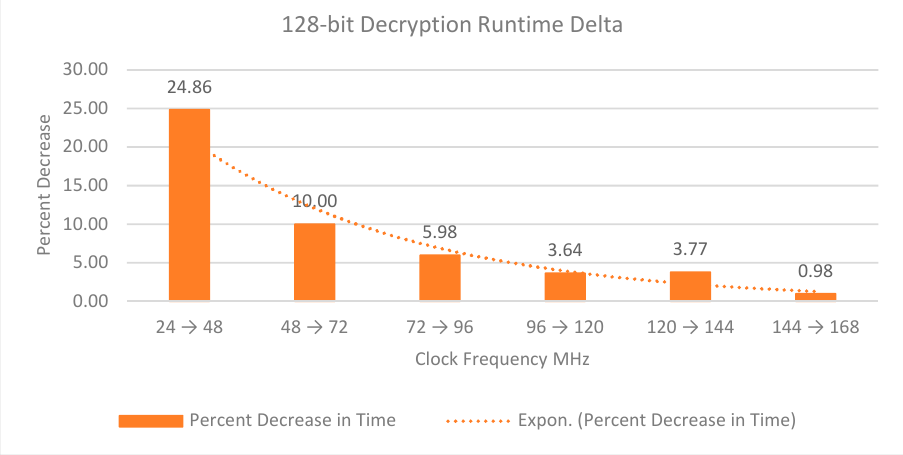
Figure A4. Relative change in decryption run time with respect to clock frequency change.